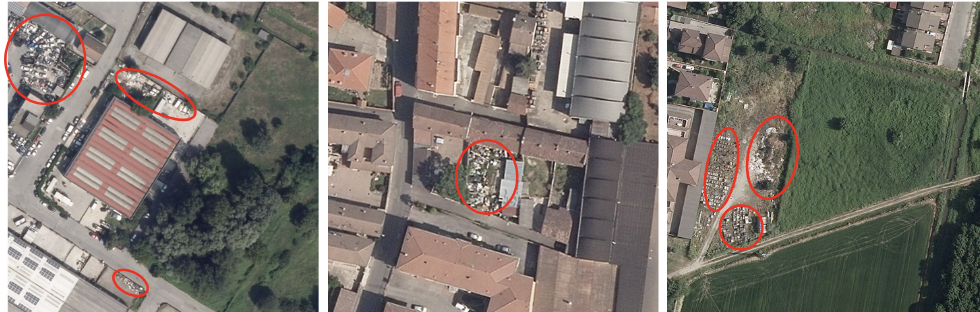
Figure 1. Examples of the presence of waste in potentially illegal sites. Red circles indicate suspicious objects. In all images accumulations of various materials and scattered waste are present. In the first image on the left, some car carcasses are abandoned at the sides of the